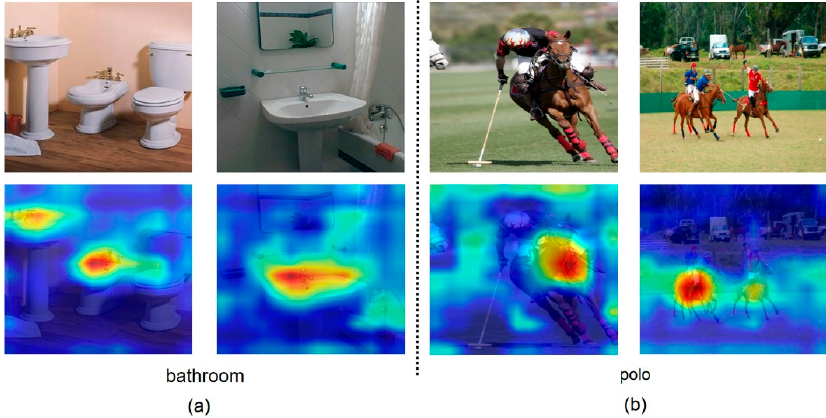
Figure 5. Some examples of Grad-CAM visualization.